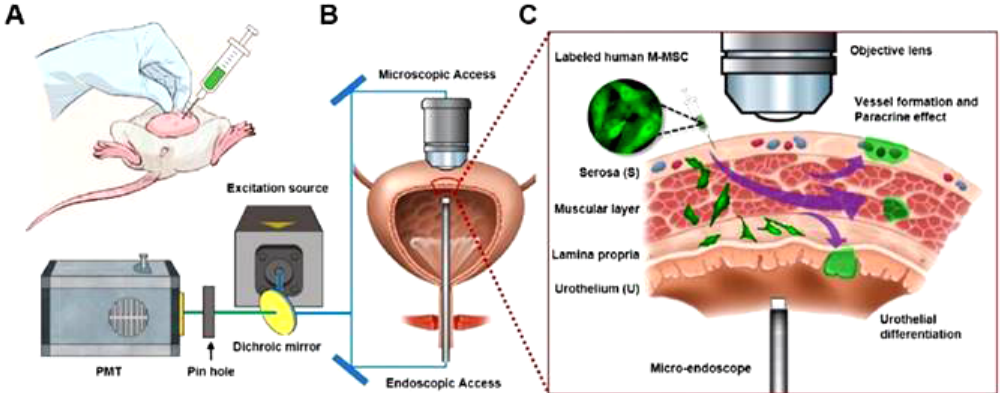
Figure 5. Diagram illustrating in vivo real-time tracking of transplanted M-MSCs in an IC / BPS rat by longitudinal intravital confocal fluorescence imaging. ( A ) Diagram illustrating the transplantation of M-MSCs via injection into the bladder wall. ( B ) Scheme displaying the process of monitoring the distribution, migration, and integration of the injected M-MSCs using the confocal imaging of the external bladder wall and micro-endoscopy of the internal bladder wall. ( C ) Representative diagram describing the migration of M-MSCs from the injection site (the serosa) to the lamina propria and urothelium. At first, M-MSCs di ff erentiate into the urothelium to restore the damaged urothelium and then assimilate into blood vessel-like structures. This figure is reproduced from articles by Ryu